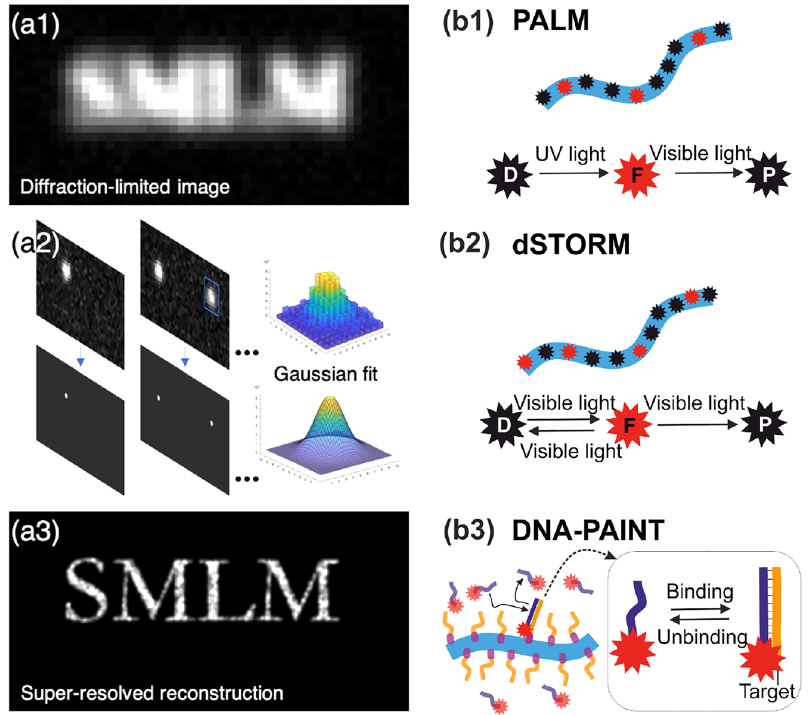
Figure 2: Basics of single-molecule localization microscopy and the most common SMLM-based techniques. (a) Principle of SMLM. In a classical fluorescence microscopy image where all the fluorophores emit simultaneously, the spatial resolution of the image is fundamentally limited by diffraction (a1). In SMLM, single emitters are stochastically activated to become fluorescent, and they are imaged as well-defined individual PSFs until photobleaching. This process is repeated typically for tens of thousands of frames. For each frame, single molecule images are identified and fitted with a Gaussian function to retrieve their center of mass (a2). Subsequently, a super-resolved pointillistic image can be reconstructed (a3), where the chosen size of the reconstruction spot typically reflects the localization precision. (b) SMLM techniques. (b1) In PALM, a fluorophore in dark state D is photoactivated by UV light, it transits into a fluorescent state F, and then undergoes photobleaching (P = photobleached state). (b2) dSTORM uses a stochastic transition of fluorophore between a dark state D and a fluorescent state F achieved by addition of blinking buffer and exposure to the visible light. (b3) DNA-PAINT is based on a transient binding of short piece of DNA carrying a fluorophore, imager strand (violet), against its complementary docking strands (yellow) which are in turn covalently bound to the target of interest, therefore bypassing the limitation of fluorophore